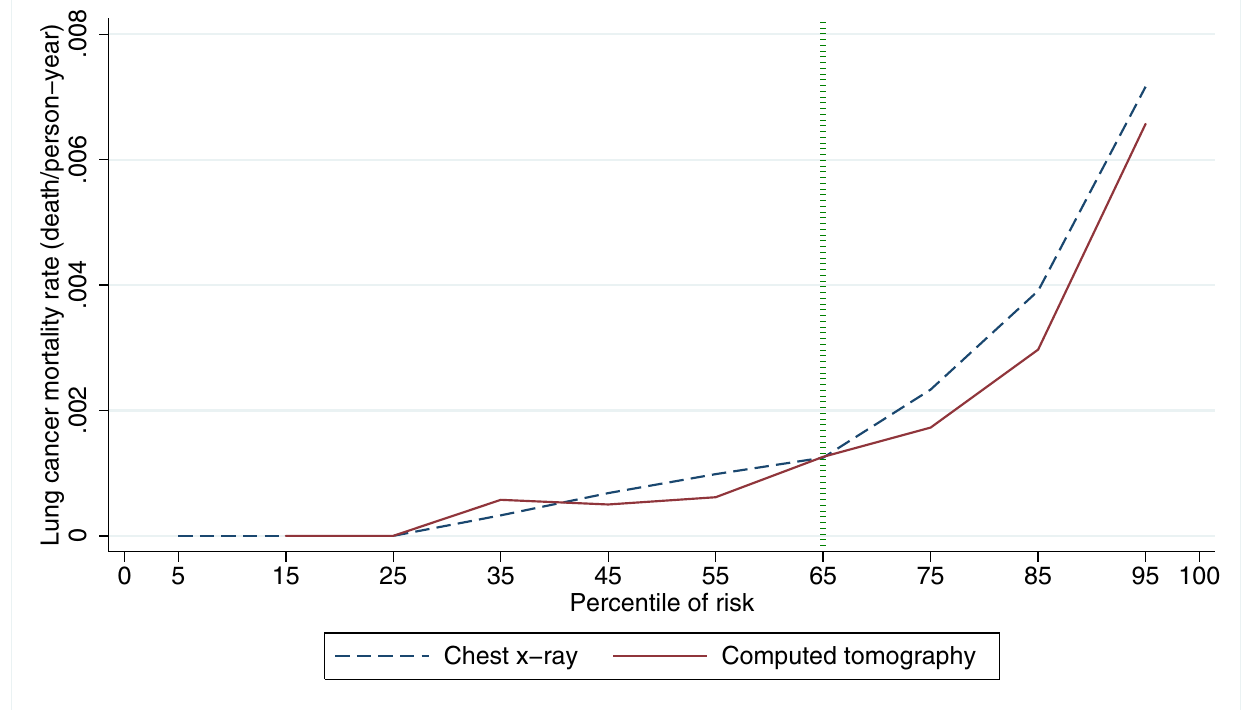
Figure 1. Lung cancer mortality rates in NLST arms by PLCO m2012 model risk deciles. PLCO m2012 model risk decile boundaries were established in PLCO control smokers. PLCO m2012 is the lung cancer risk prediction model described in